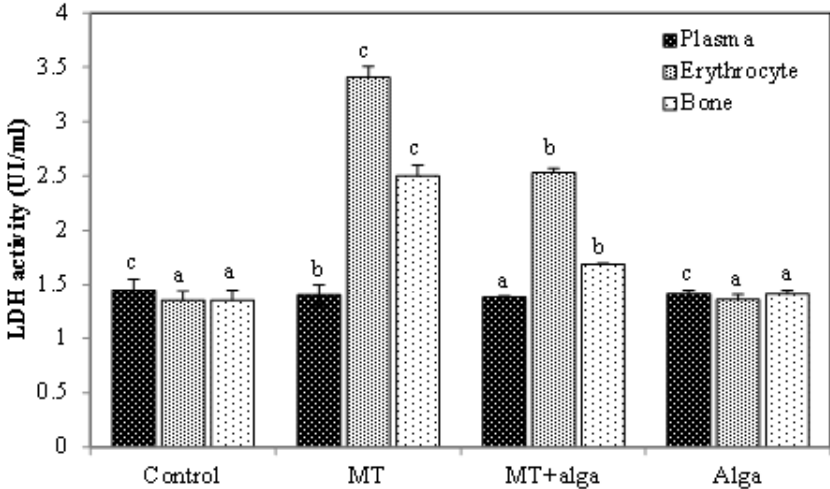
Figure 5. Lactate dehydrogenase activity in plasma, erythrocytes and bone in different groups of rats. a,b,c indicate significant differences between experimental groups ( p < 0.05).